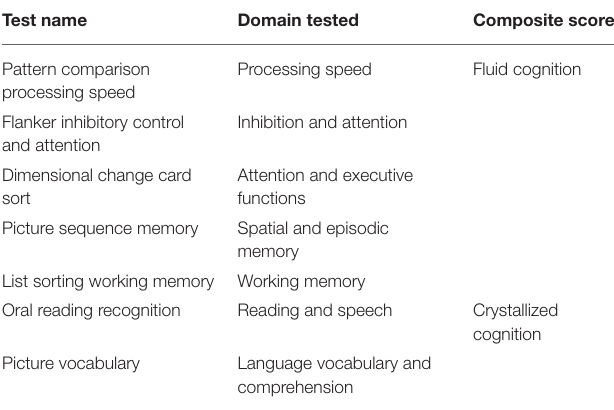
TABLE 1 | Cognitive and quality of life